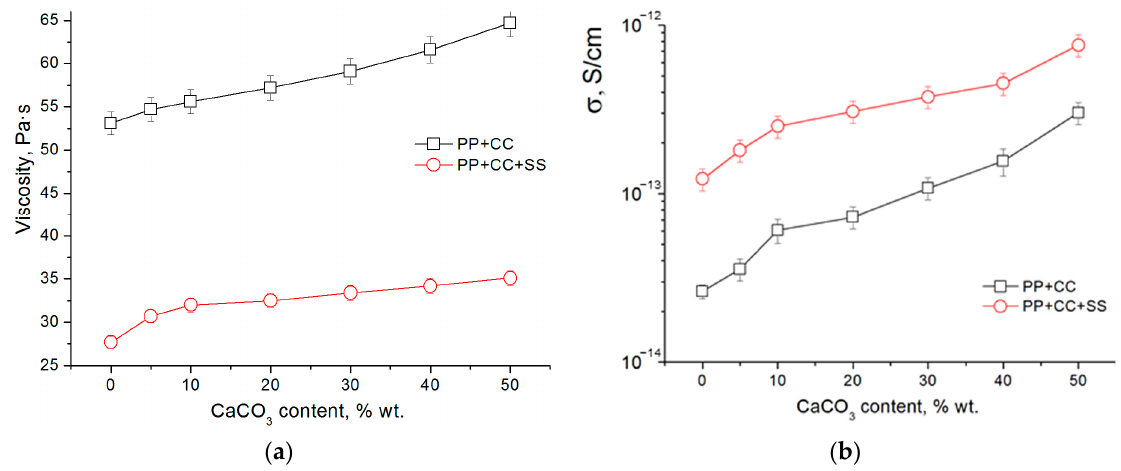
Figure 2. Effect of CaCO 3 content on the viscosities ( a ) and conductivities ( b ) of polypropylene composites.